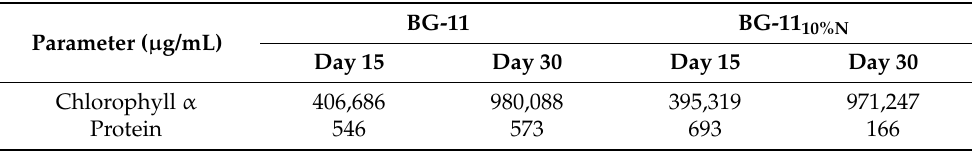
Figure 2. Growth curve of Synechococcus sp. GFB01. 30-day cultivation expressed in terms of absorbance at 750 nm, in log. The culture media tested had 1.5, 0.15 and 0 g/L of sodium nitrate. Table 1. Chlorophyll α and protein quantification ( µ g/mL) in Synechococcus sp. GFB01. Growth in complete medium and under nutritional stress, at day 15 and